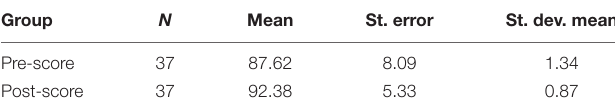
TABLE 5 | Pair sample statistics (experimental class).